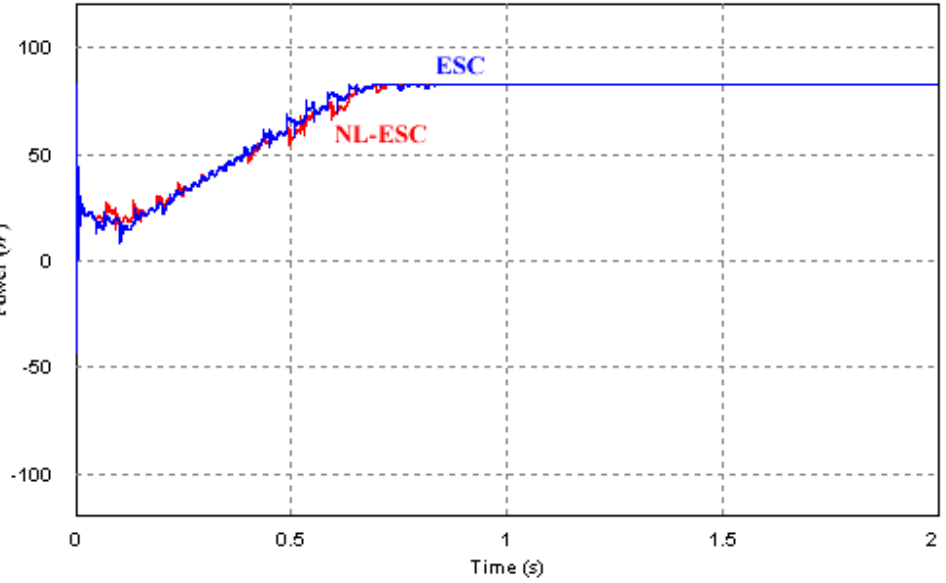
Figure 10. Transient of output power from D Transient of output power from D